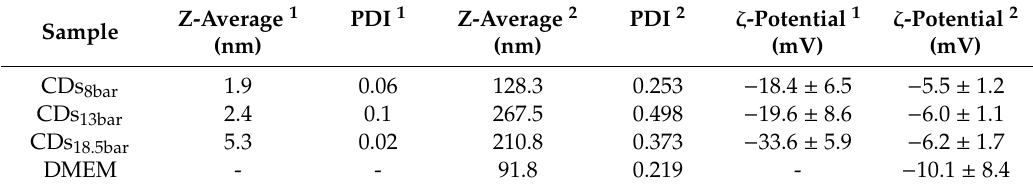
Table 2. Z-Average, PDI and ζ -Potential of red CDs 18.5bar , CDs 13bar and CDs 8bar (0.25 mg mL − 1